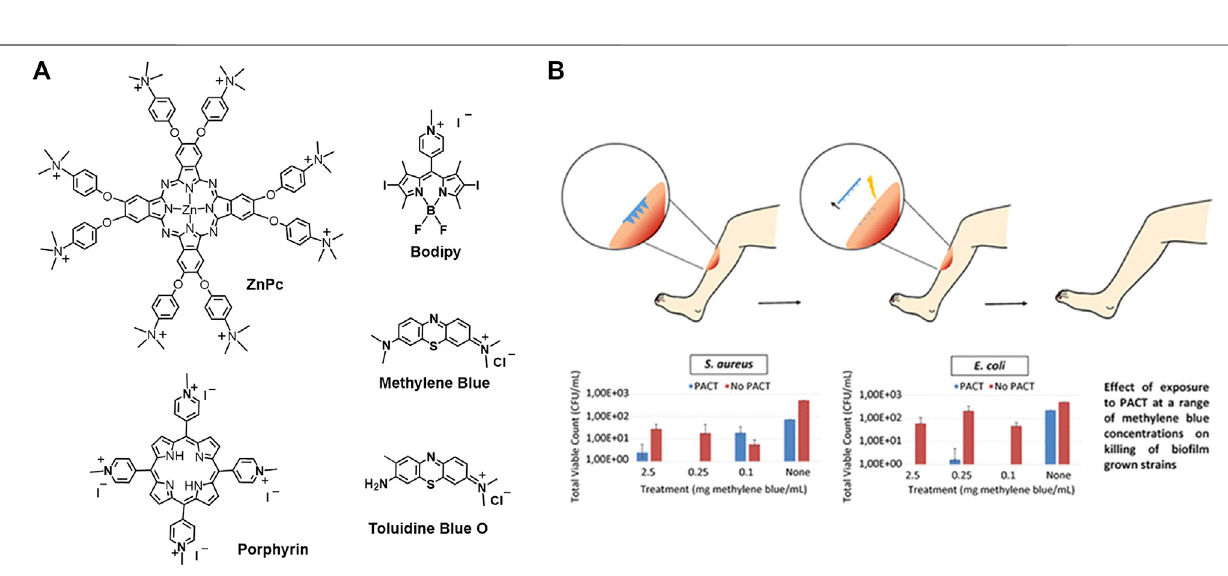
Frontiers in Bioengineering and Biotechnology |